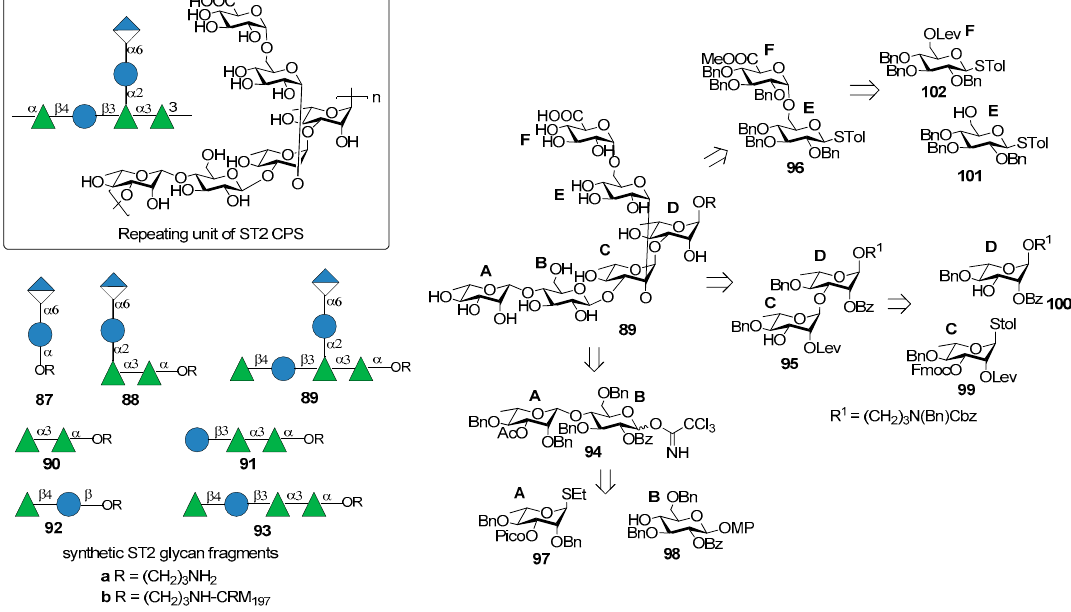
Figure 11. Repeating unit of Streptococcus pneumoniae 2 CPS and synthetic ST2 glycan fragments reported in [76].